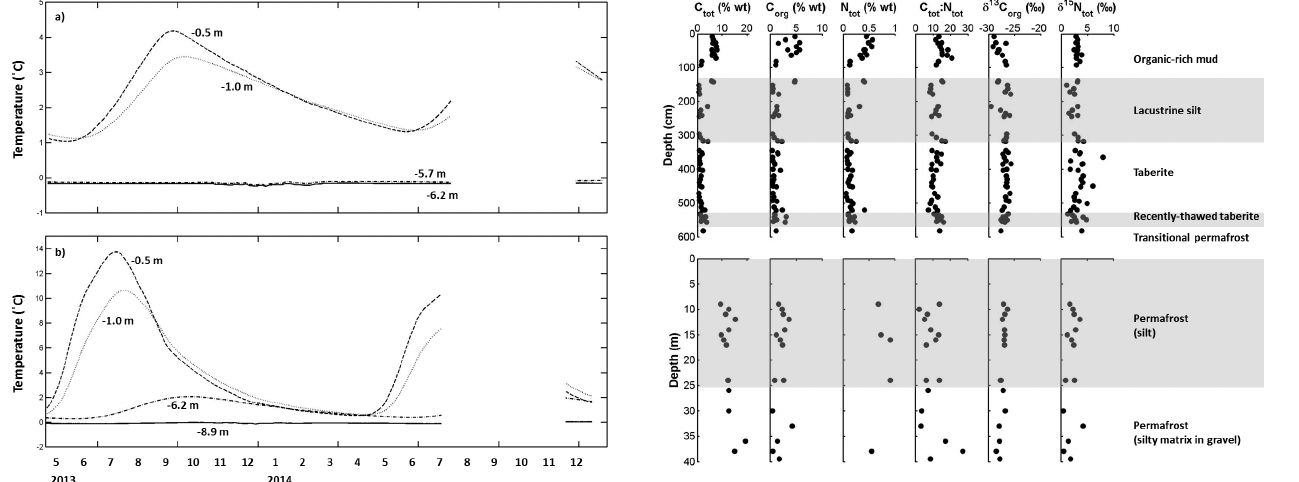
Figure 3. Vertical profile temperatures measured in the lake cen- ter ( < 1m from BH14; a ) and 6.1m offshore of the southwest- ern thermokarst margin (b) . Negative depth values indicate depth from the sediment–water interface (0m) at each of the examined boreholes. Loggers did not record temperature between 25 July and 11 November 2014.